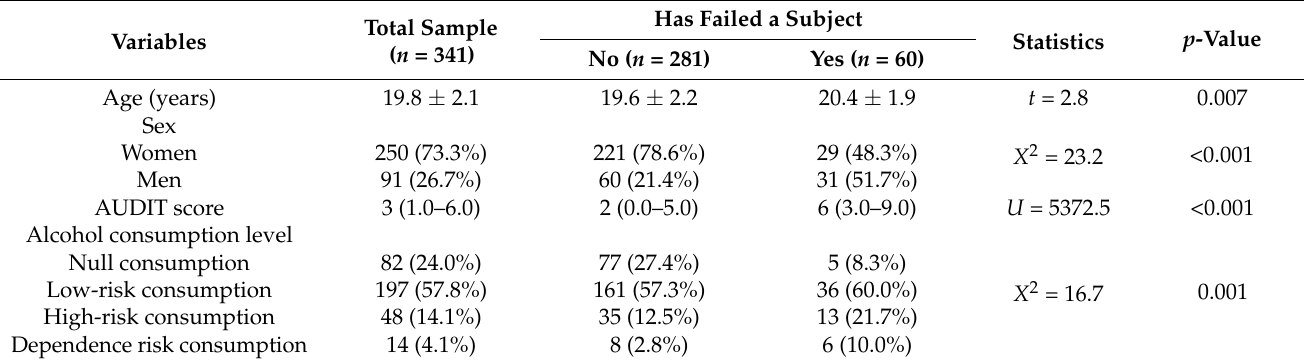
Table 1. Descriptive results of the students’ sample of the